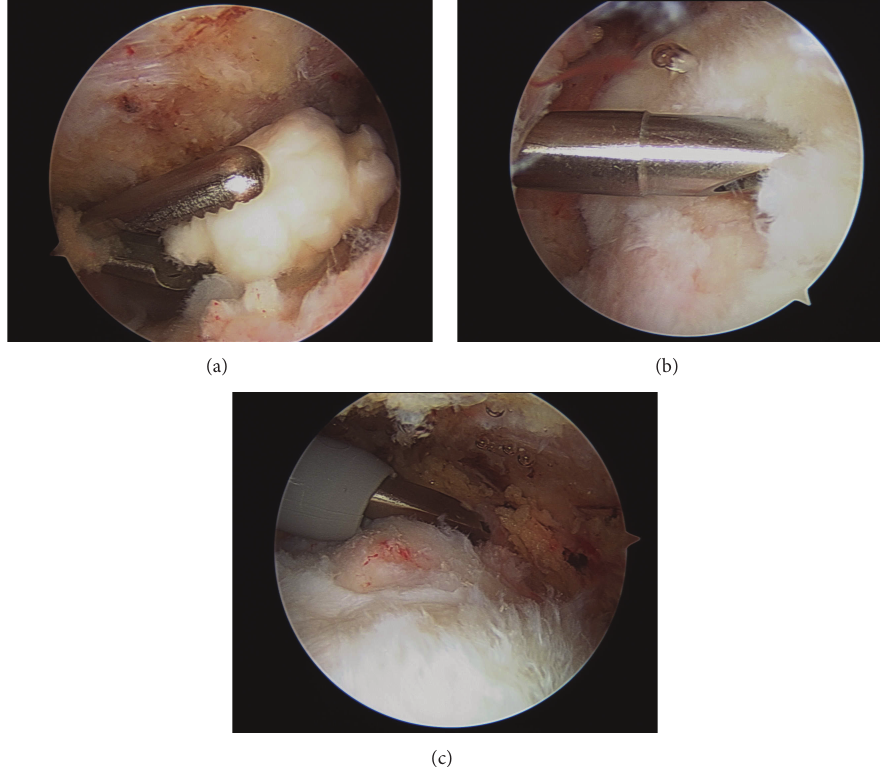
Figure 3: Arthroscopic view into the subacromial space showing (a) large subacromial loose body and ((b), (c)) 7-8 mm deep, partial- thickness, bursal-sided supraspinatus tear.